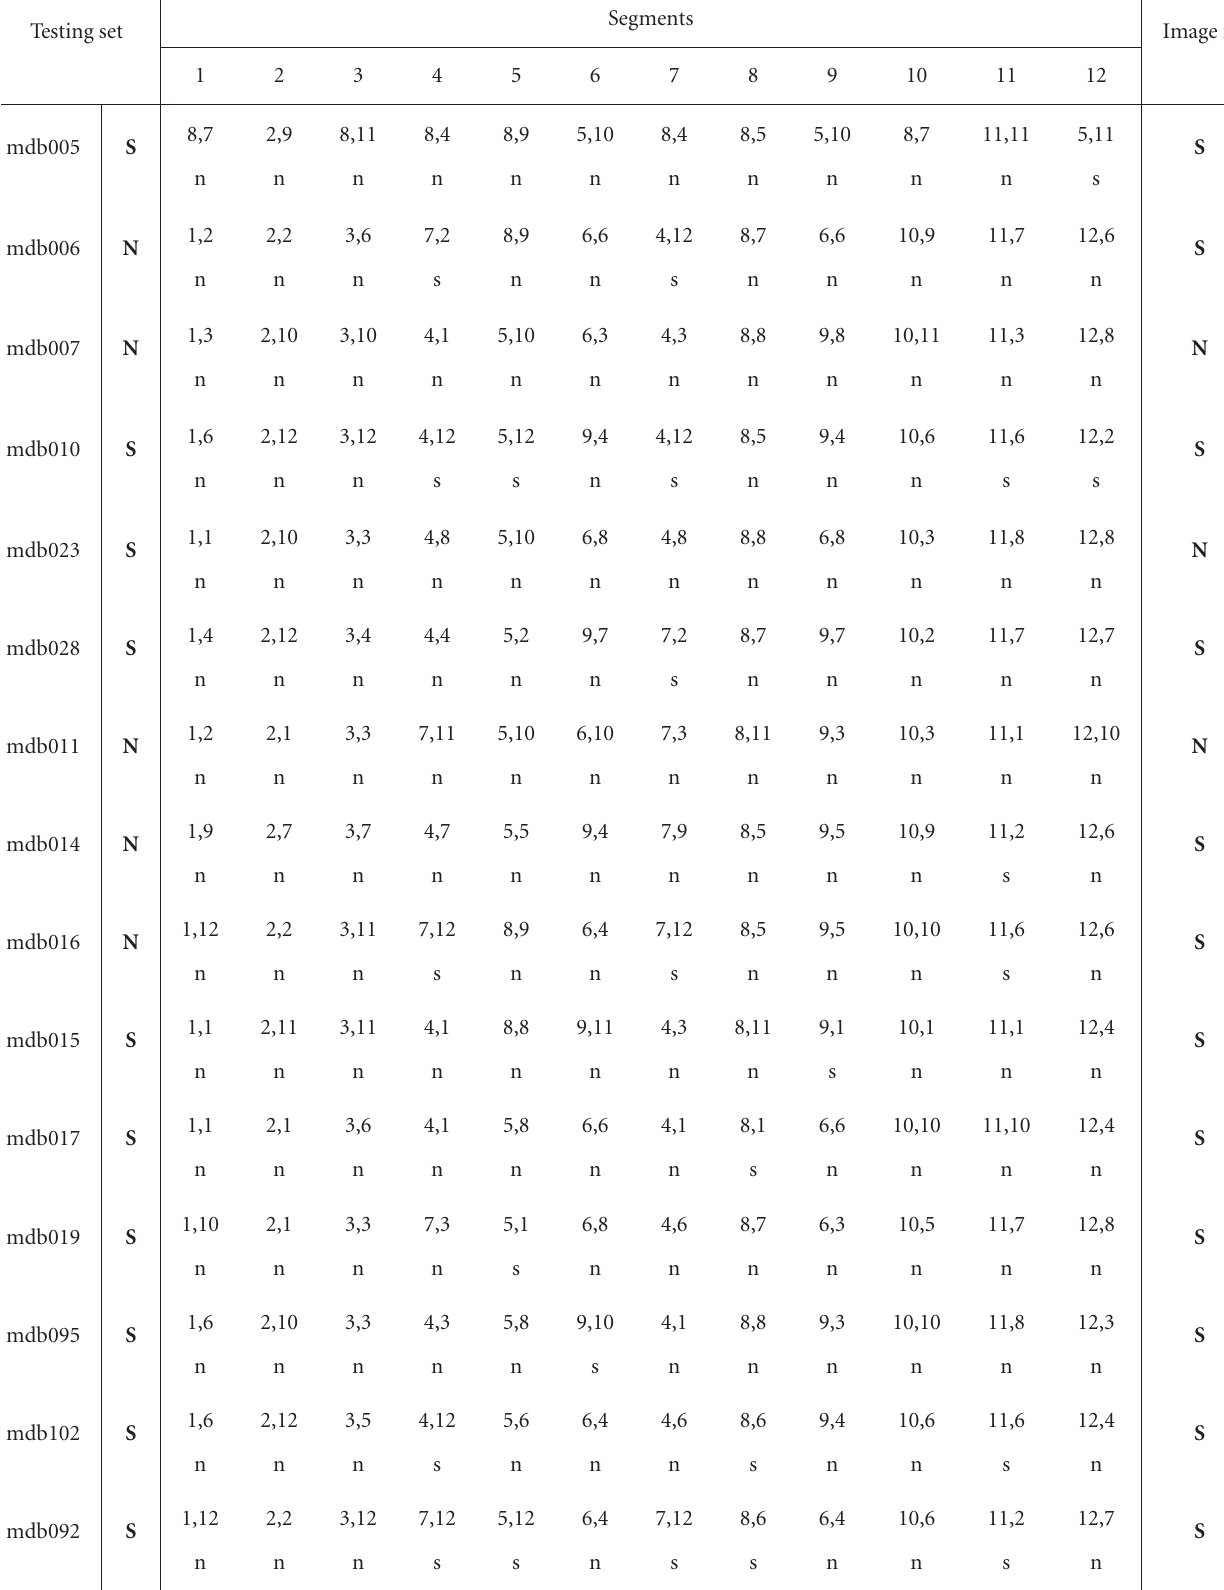
Table 4: Results of using curvilinear modeling and PCA with Euclidean distance. Note: first number indicates the block number and second one signifies the image number in training